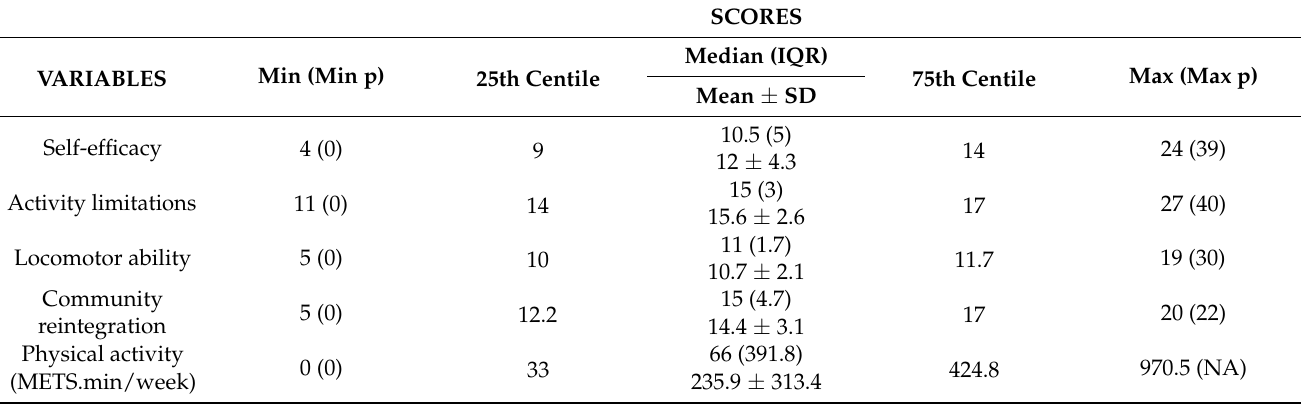
Table 2. Participants’ self-efficacy, activity limitations, locomotor ability, community reintegration, and physical activity scores.